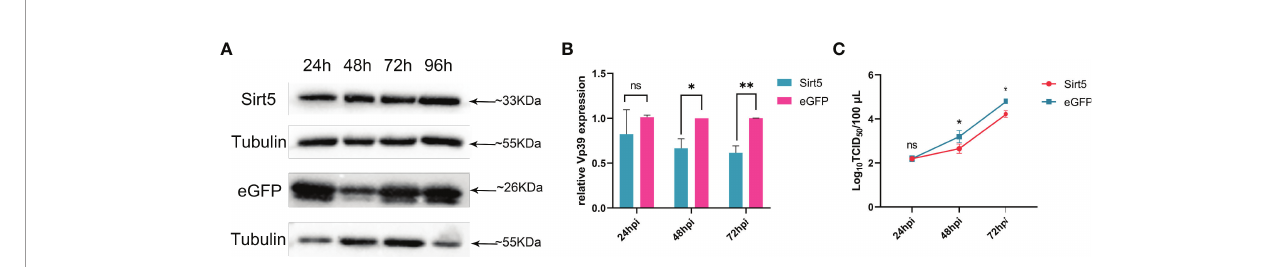
FIGURE 5 | Over-expression of BmSirt5 inhibited the replication of BmNPV. (A) The expression level of exogenous BmSirt5 in BmN cells was determined by Western blotting with fl ag antibody at 24, 48, 72 and 96 h post transfection. BmN cells transfected with pIEX-eGFP were used as a negative control. (B) Quanti fi cation of BmNPV gene Vp39 expression by qRT-PCR in BmN cells transfected with pIEX-BmSirt5 or pIEX-eGFP at 24, 48 and 72 h after BmNPV infection. (C) Viral titer determination using the TCID 50 assay in supernatants of BmN cells transfected with pIEX-BmSirt5 or pIEX-eGFP at 24, 48 and 72 hpi. Each bar represents the mean ± SD. *p < 0.05, **p < 0.01. ns, not signi